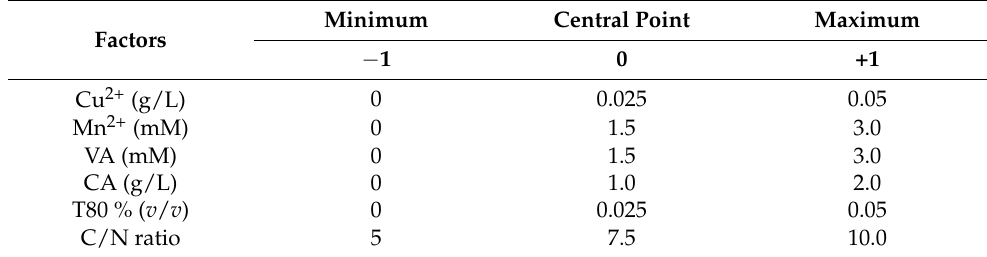
Table 1. Factors and levels used in design of experiment for ligninolytic enzyme production by P. sanguineus 2512 in submerged